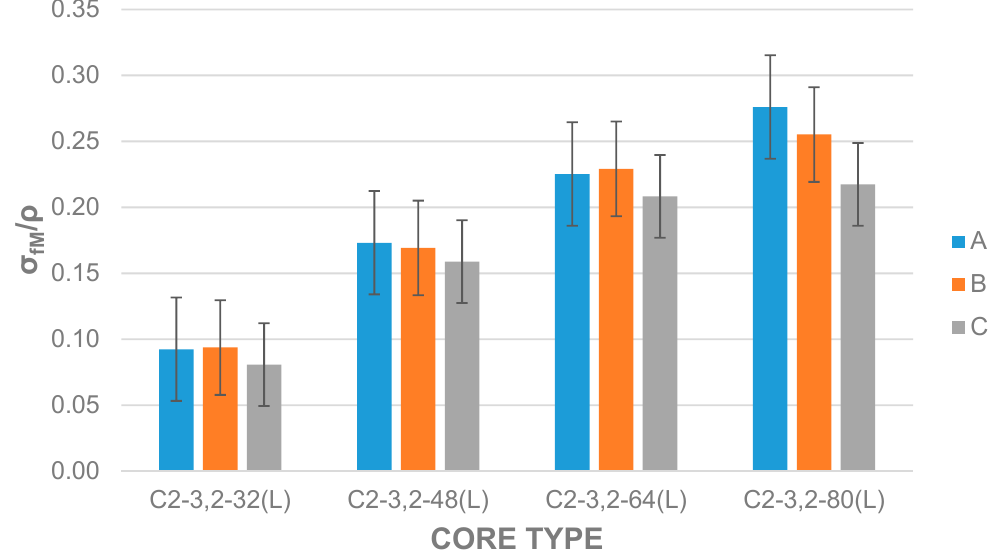
Figure 6. Specific strengths of sandwich constructions (A–C). C2-type honeycomb used with 3.2 mm individual mesh size and various densities (29, 48, 64, and 80) kg · m − 3 , honeycomb orientation: